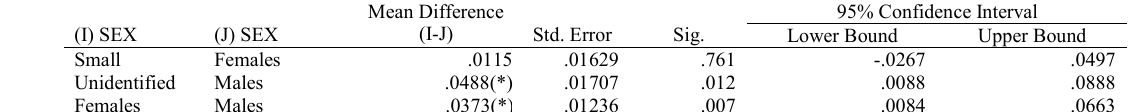
Table 3. Tukey test comparison table for the length/weight residuals of Atherinella brasiliensis. * The mean difference is significant at the .05